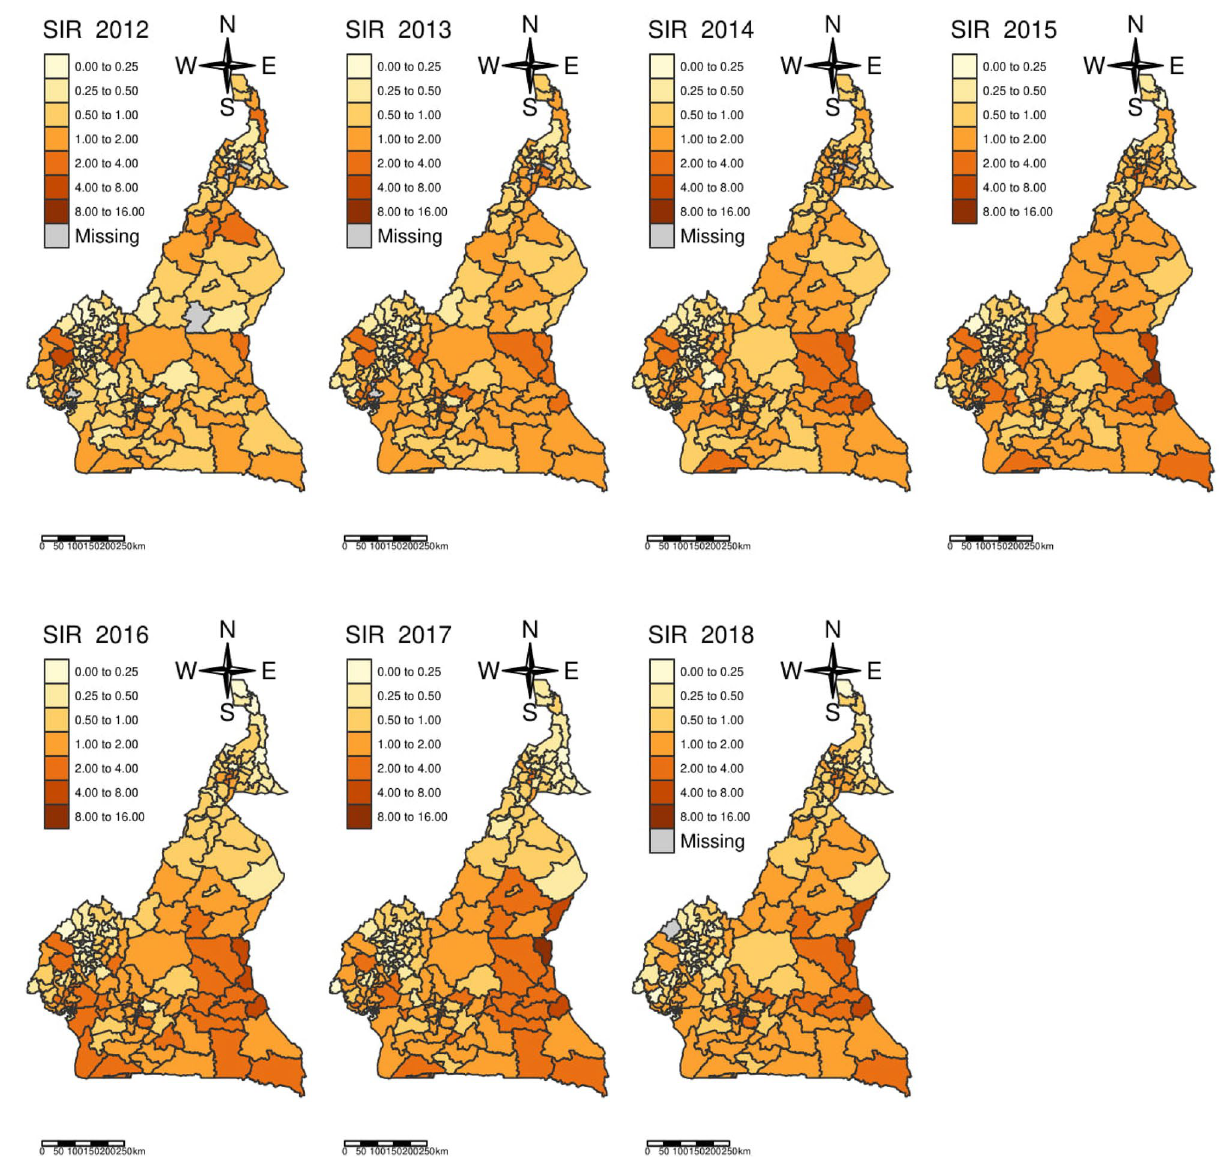
Figure 3. Map of malaria standardized incidence ratio in under-fives between 2012–2018. The SIRs are presented by year and by health districts for the years 2012 to 2018. The map was generated with tmap package of R software version 4.0.2 (URL: https:// cran.r- proje ct. org/ web/ packa ges/ tmap/ vigne ttes/ tmap- getst arted.